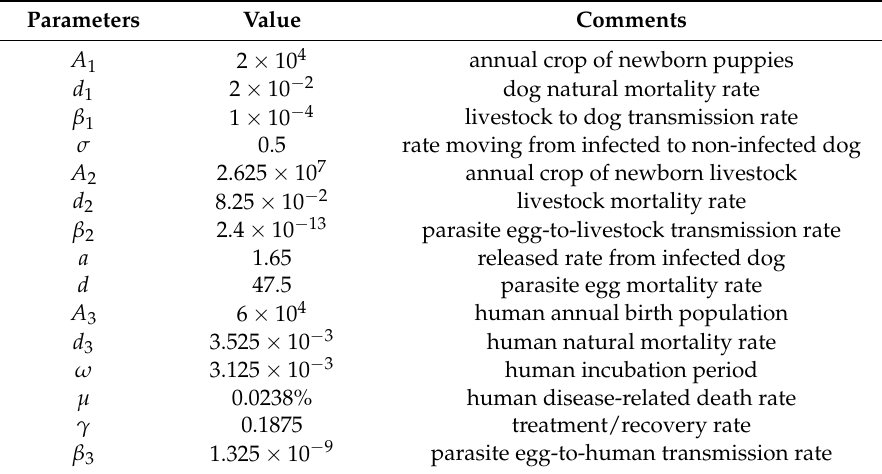
Table 2. Parameters and their values (unit: quarter − 1 ).